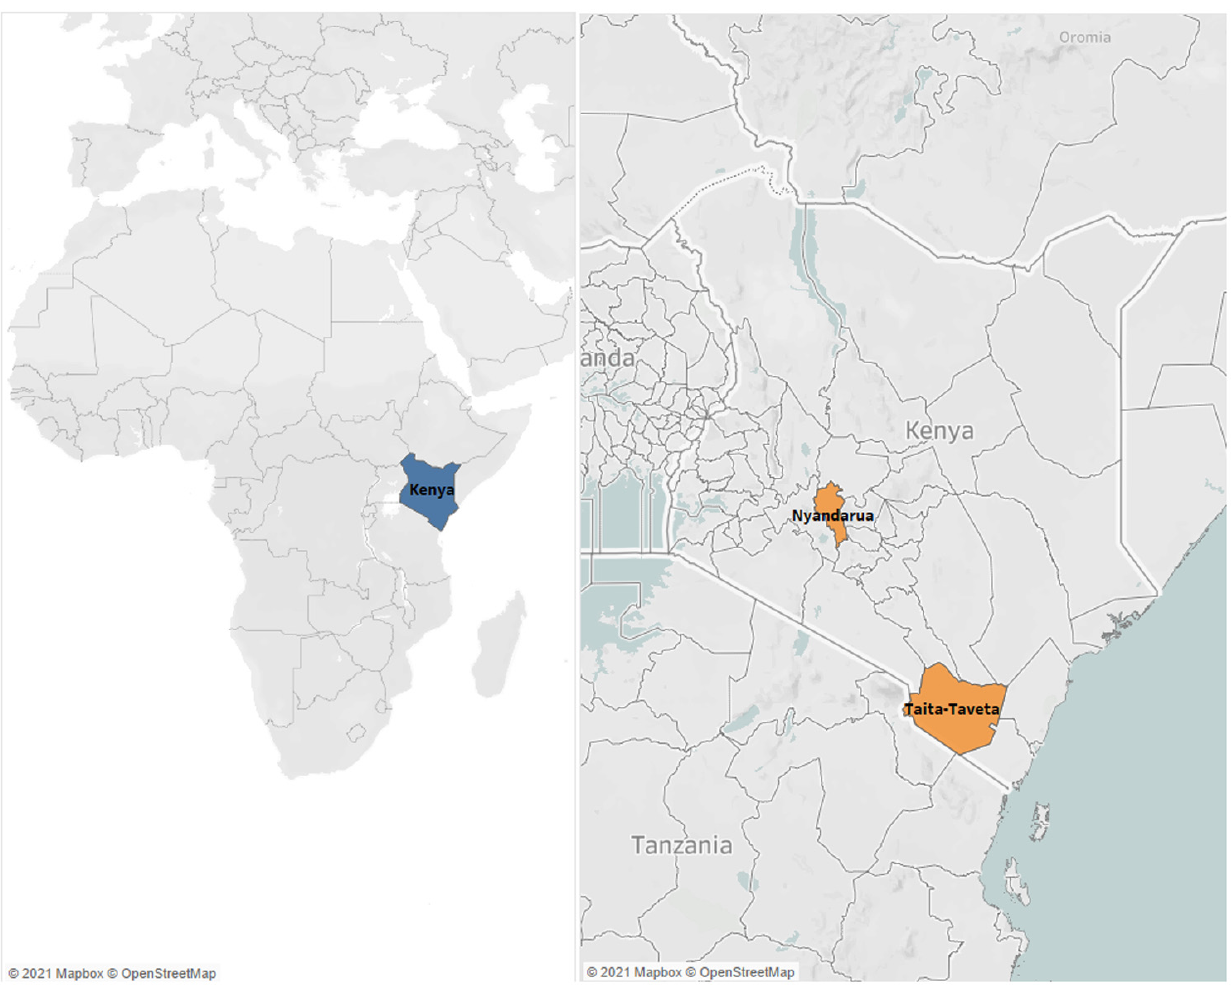
Figure 1. Location of study areas. The map on the left shows the position of Kenya (highlighted in blue) within Africa. The map on the right shows the study areas, Nyandarua and Taita-Taveta (highlighted in orange) within Kenya.